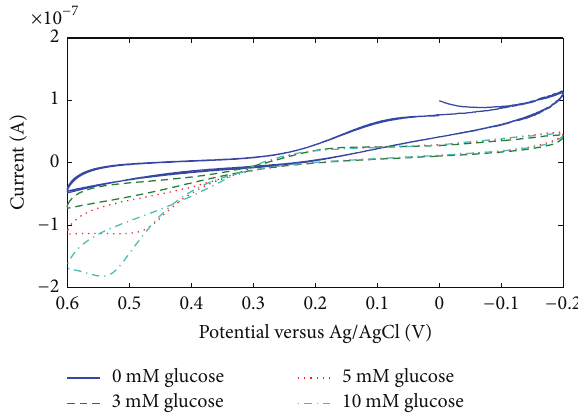
Figure 17: In vitro cyclic voltammetric sensing of glucose.